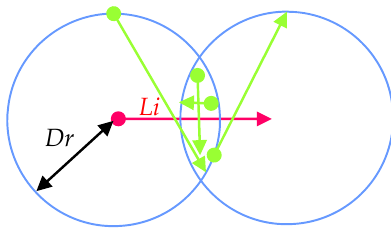
Figure 2. Special cases of definition 1 (the dots represent O, and the arrows represent D).